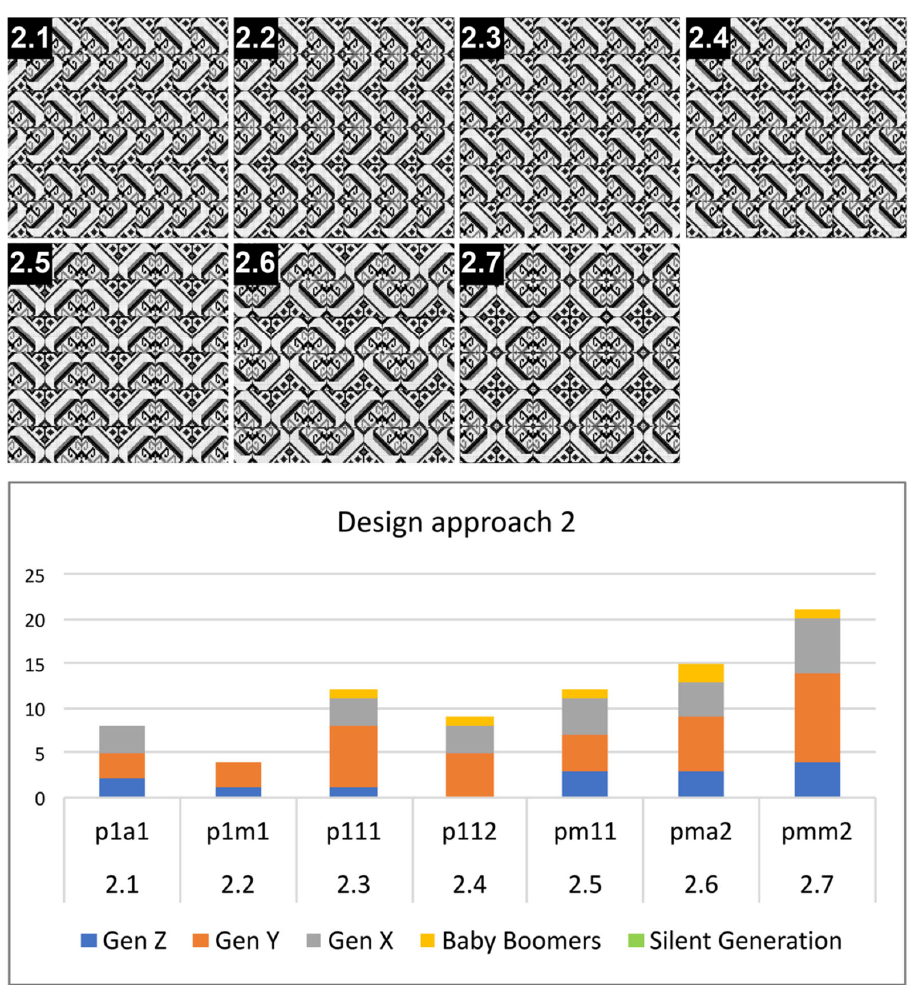
Figure 15. Design approach 2: seven frieze patterns and respondents’ preferences. (Illustration by Kunkhet and Chudasri).